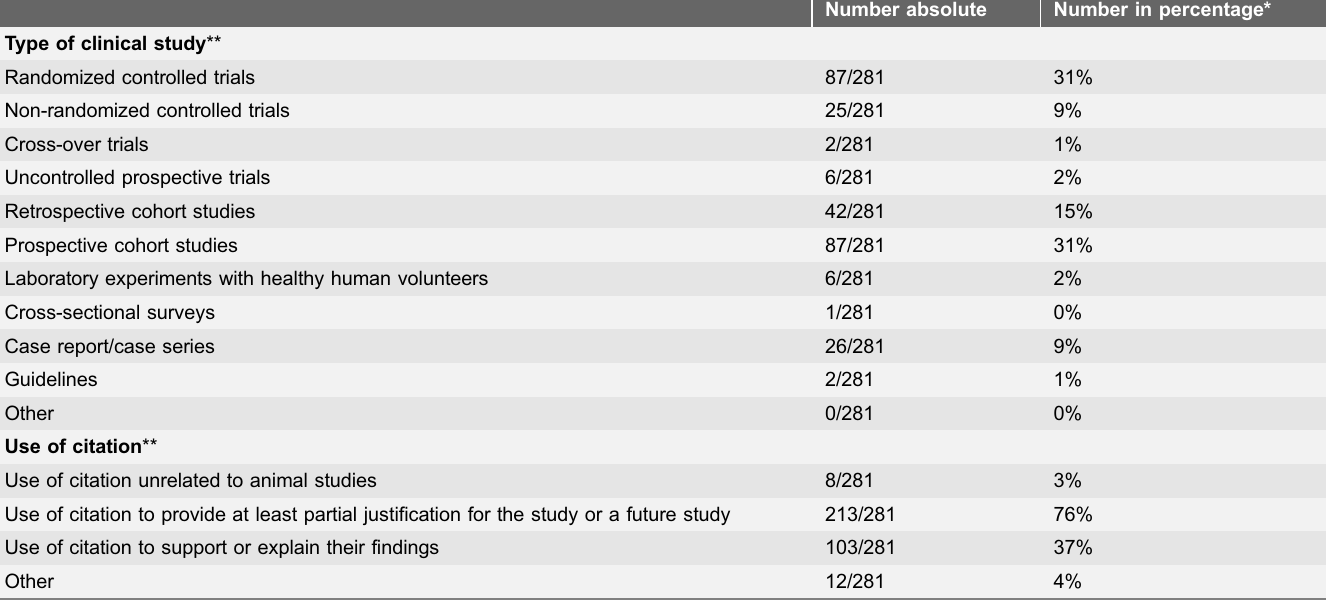
Table 4. Influence of systematic reviews of preclinical research on clinical